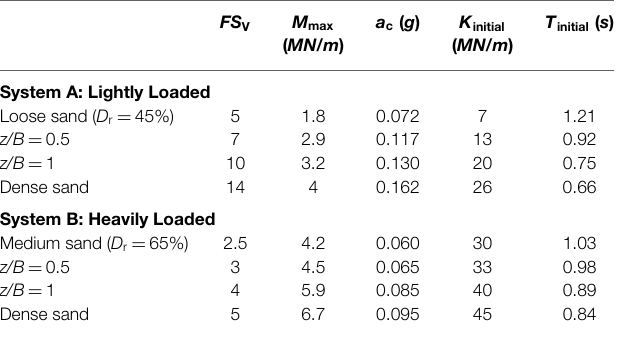
TABLE 2 | Summary of monotonic pushover loading .